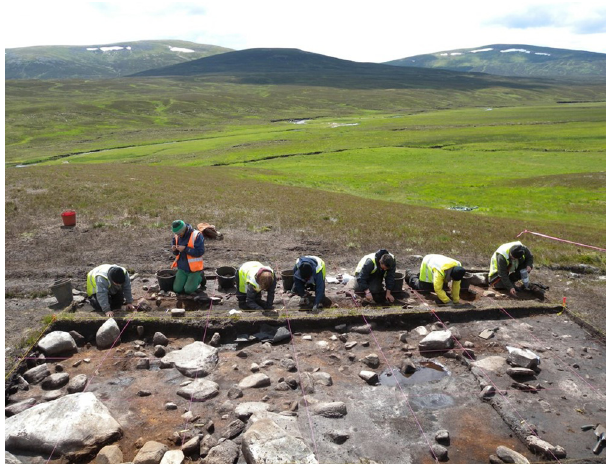
Figure 1: Excavation at Caochanan Ruadha, Cairngorms 2014. Note eroded footpath immediately behind the trench and running across the photograph © Graeme